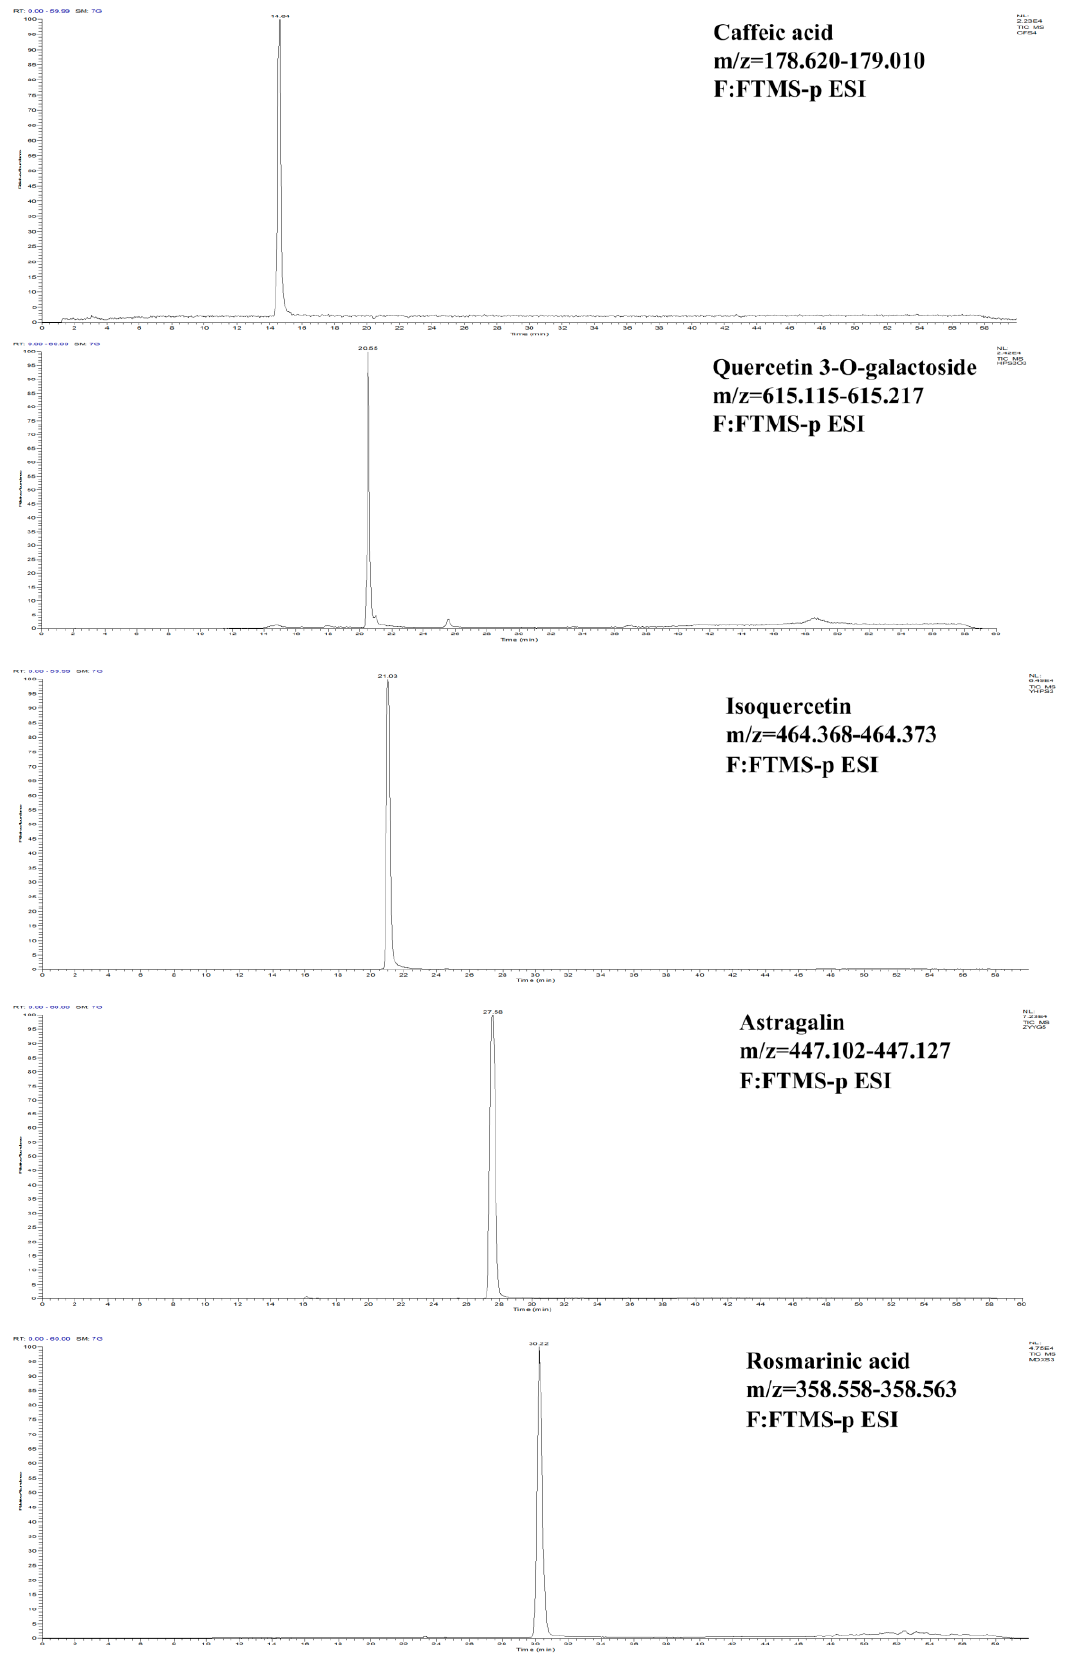
Figure 2. Extract ion chromatogram of standards.